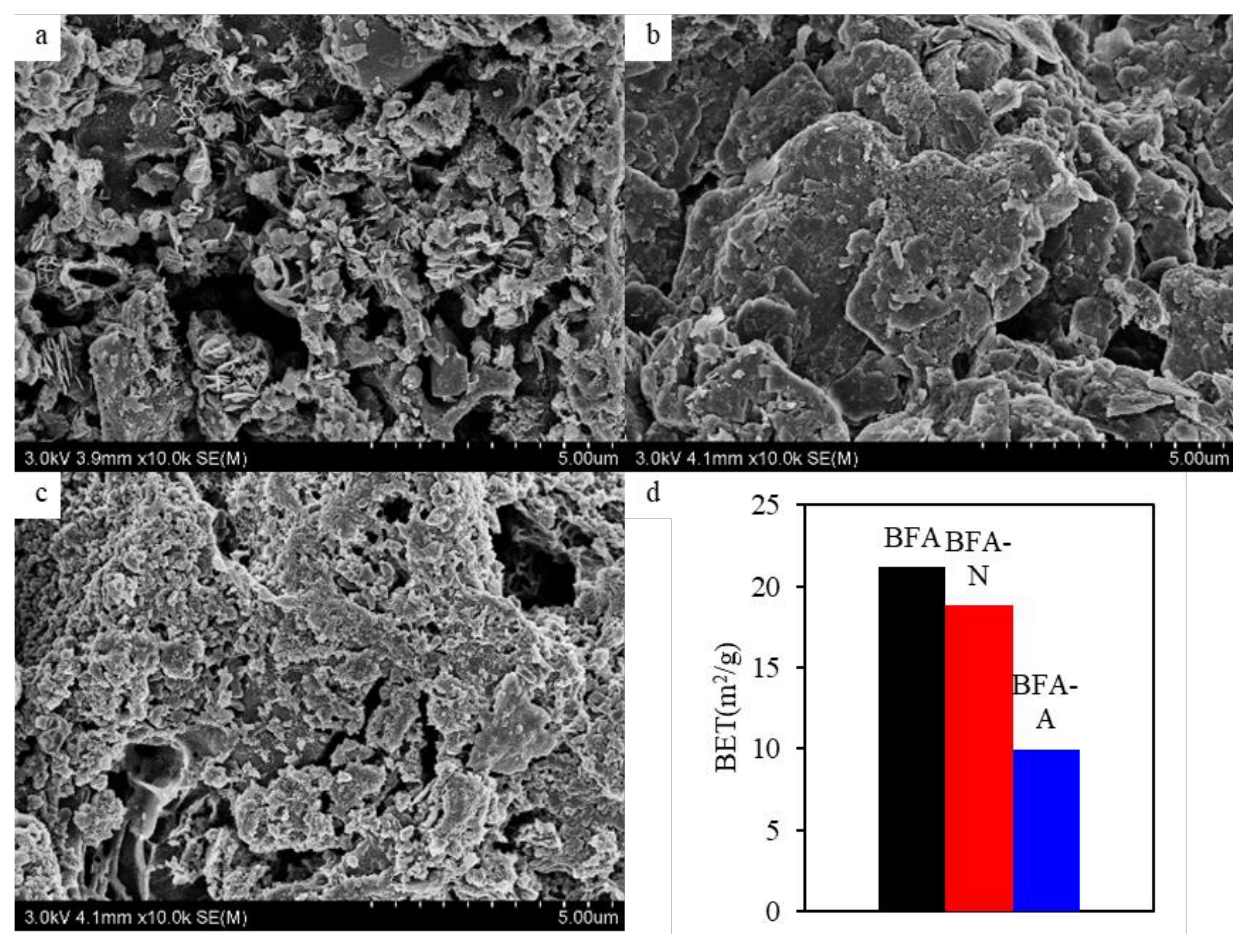
Figure 3. ( a ) SEM of BFA, ( b ) SEM of BFA-N, ( c ) SEM of BFA-A, and ( d ) BET.